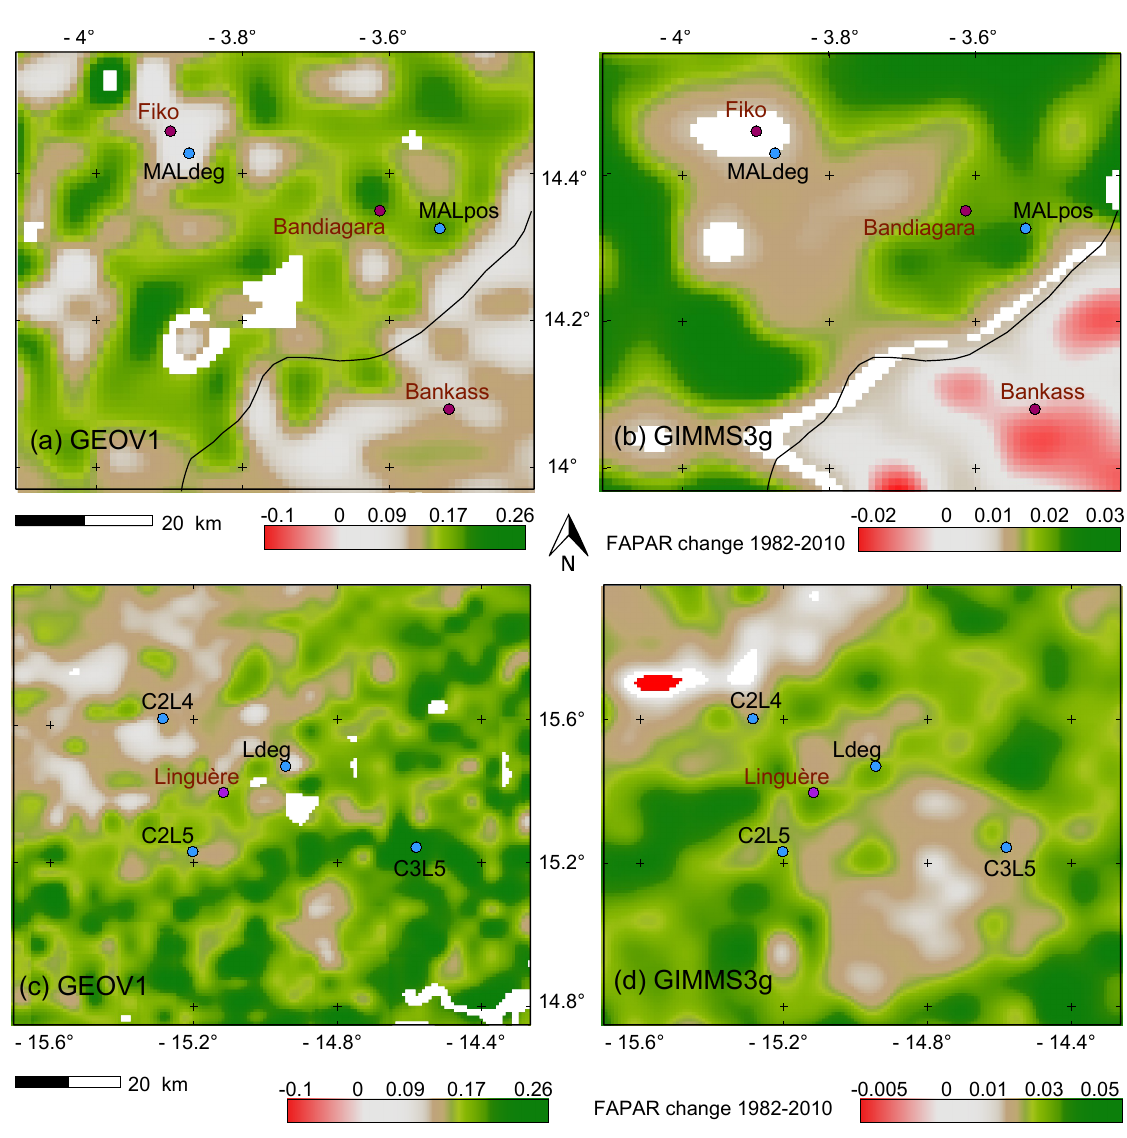
Figure 5. FAPAR change in the Bandiagara ( a , b ) and Lingu`ere ( c , d ) region from 1982 to 2010 as evaluated with the GEOV1 FAPAR product (left), as well with the GIMMS3g FAPAR product